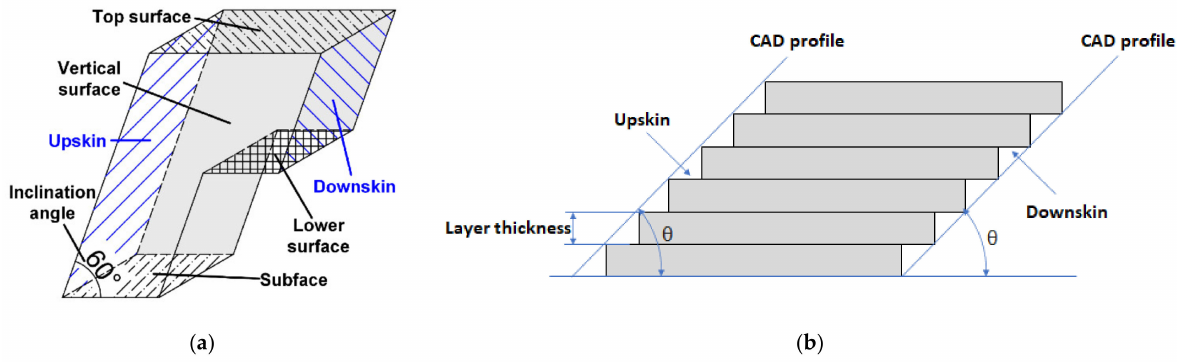
Figure 4. ( a ) schematic presentation of the different surface types on a part fabricated by L-PBF [93]. ( b ) Schematic presentation of the staircase